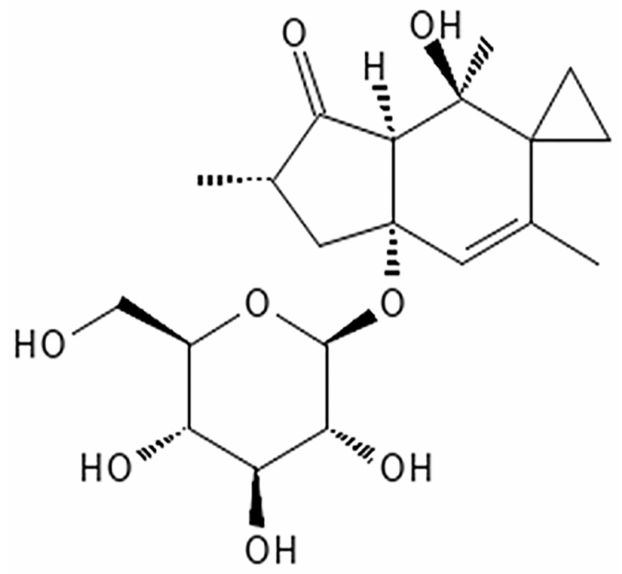
Figure 2. Structural formula of ptaquiloside